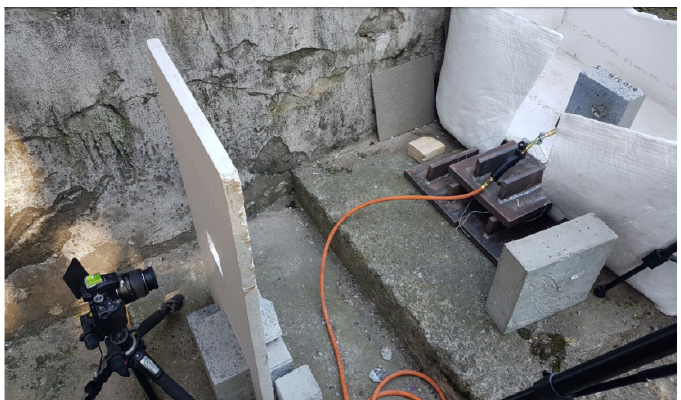
Figure 4. Test stand used for the simple flame test.